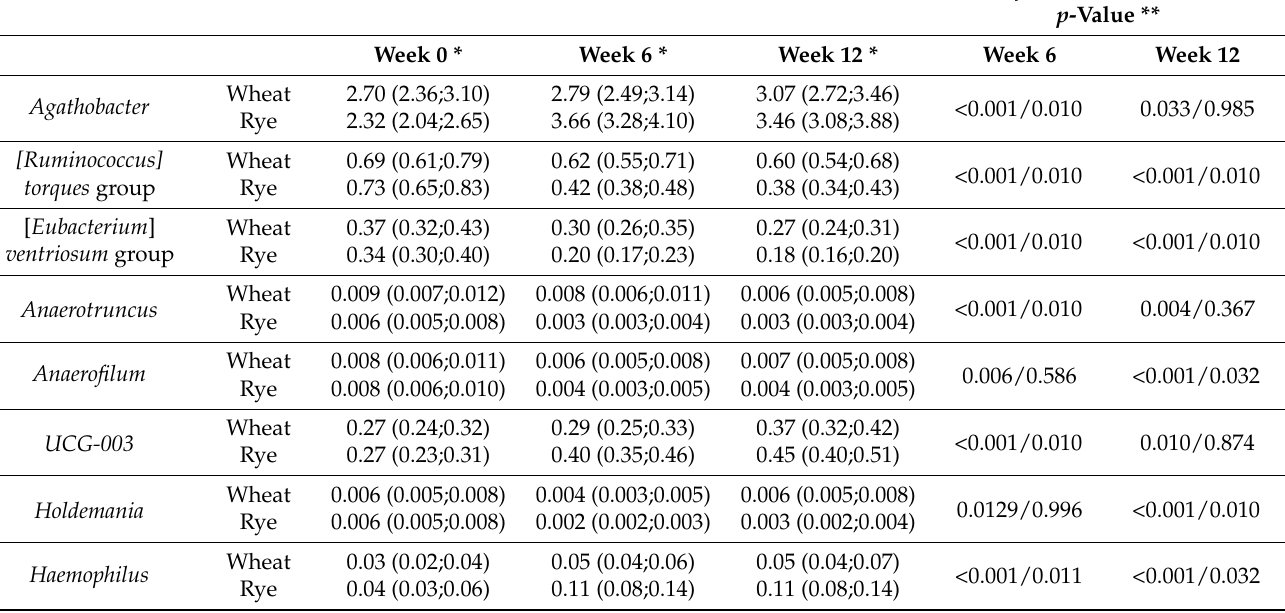
Table 2. Relative abundance of bacteria that differed significantly between the rye and the wheat group at either week 6 and/or week 12 after correction for multiple testing. In total, 110 bacteria were tested, 45 differed significantly between the groups before FDR correction, and 8 remained significant after FDR correction. The 8 bacteria that differed significantly after FDR correction are included in this table while the remainder of the 45 can be found in Supplementary Table